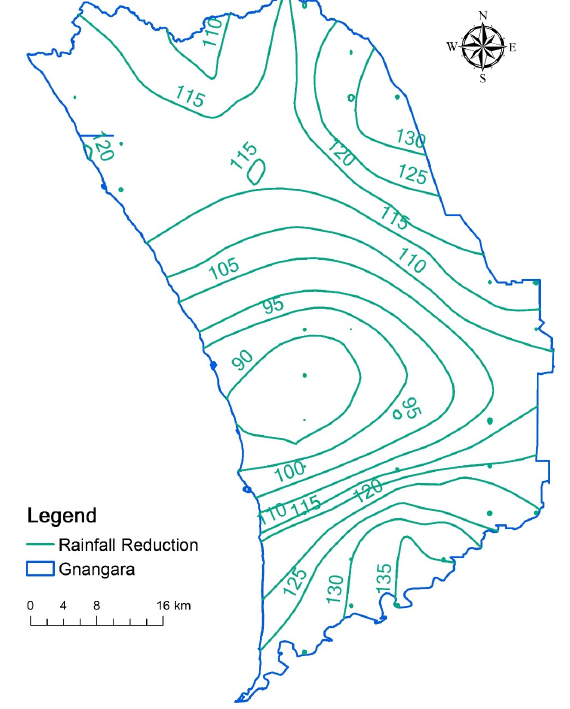
Figure 16. Distribution of the reduction in rainfall (mm) within the Gnangara region.